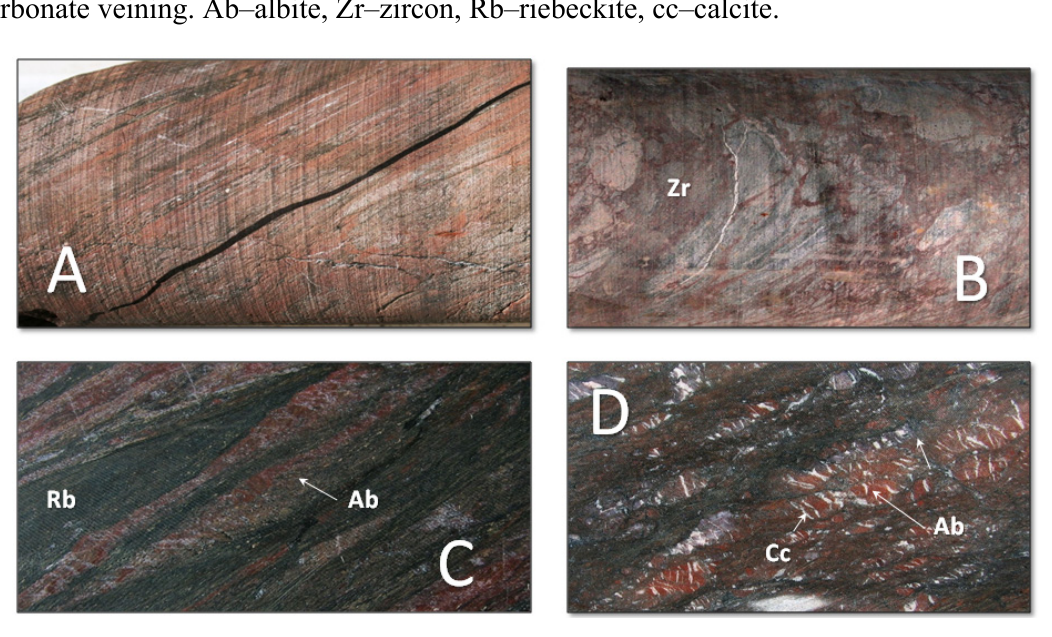
Figure 4 . Relationship of uranium deposits to regional albititisation. ( A ) typical mylonite ore; ( B ) hydrothermal breccia ore with zircon-U matrix; ( C ) Early albitite fragments in riebeckite schist with later calcite veins; ( D ) An example similar to (C) with more intense carbonate veining. Ab–albite, Zr–zircon, Rb–riebeckite,